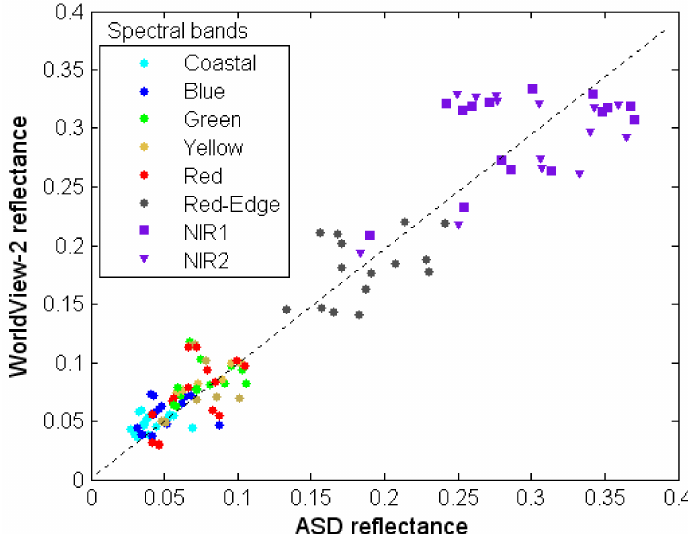
Figure 15. Comparison of reflectances measured (ASD) and estimated (REFLECT) for the World-View-2 image of 5 July